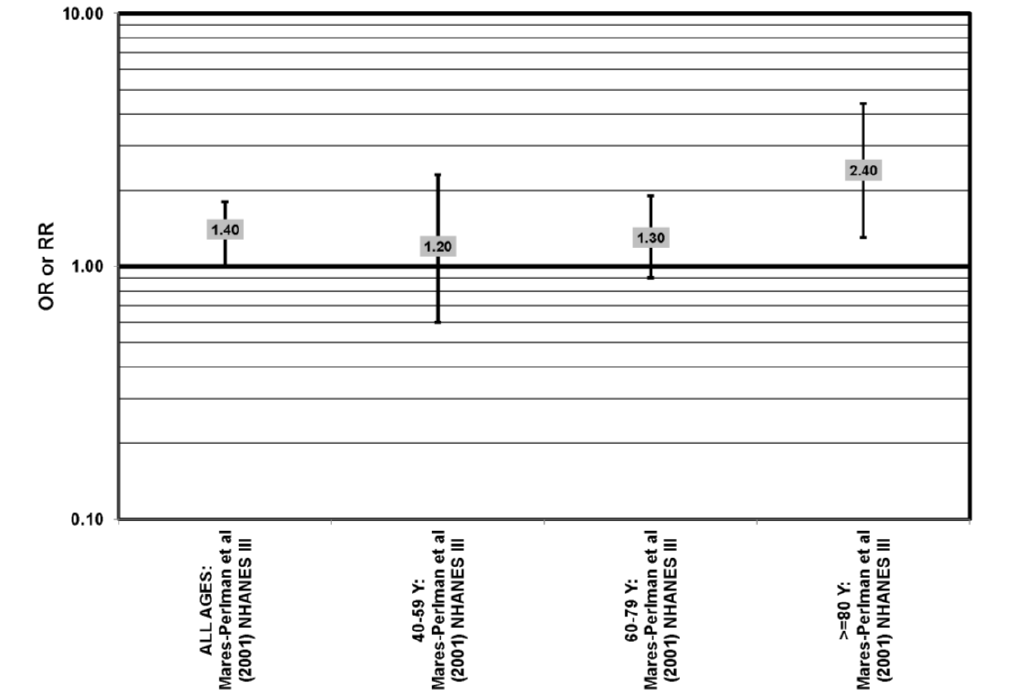
Figure 27. Odds or risk ratio for soft drusen; high vs. low intake of lutein and zeaxanthin:retrospective